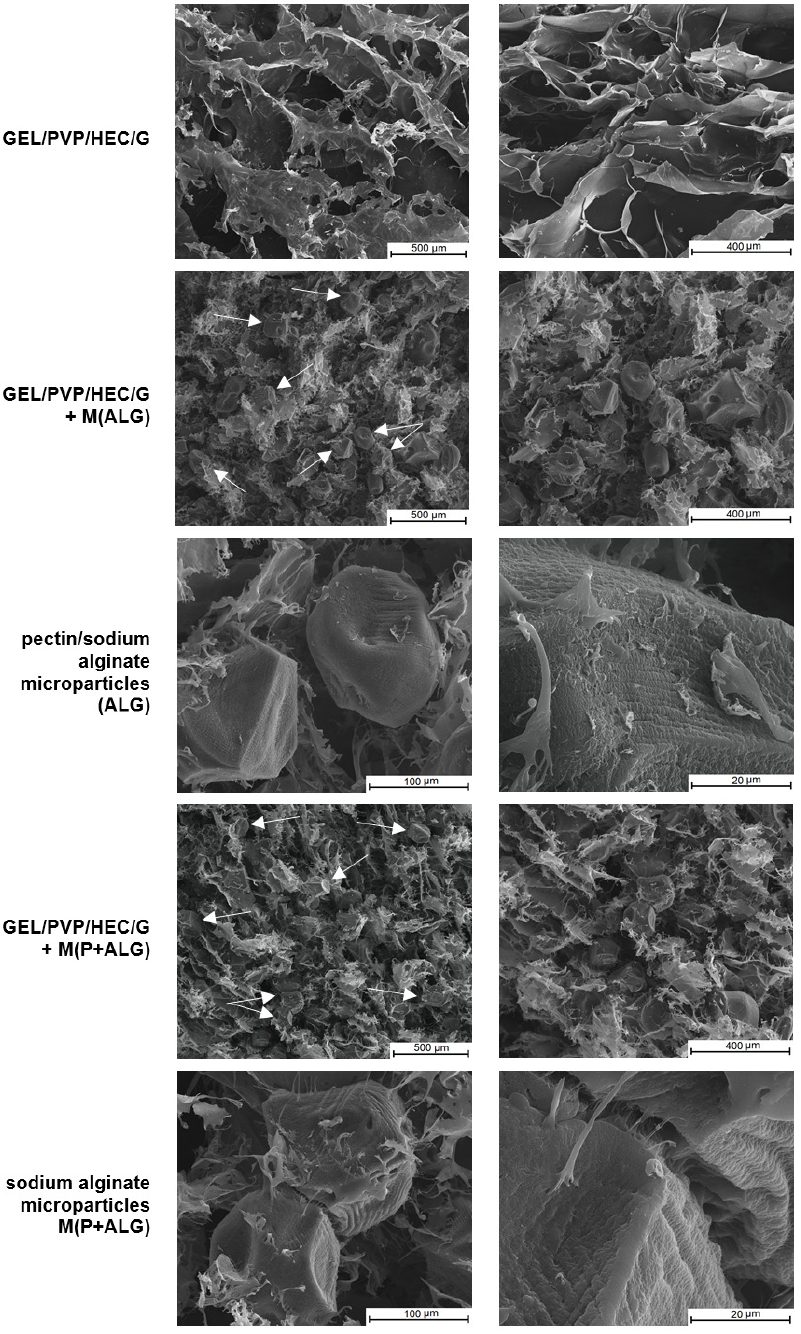
Figure 4. SEM images of the prepared materials with and without microspheres—magnification ×150, ×250 (arrows indicate the location of microspheres in the matrices), SEM images of microparticles in the matrices along with their surfaces—magnification ×1000, ×5000.